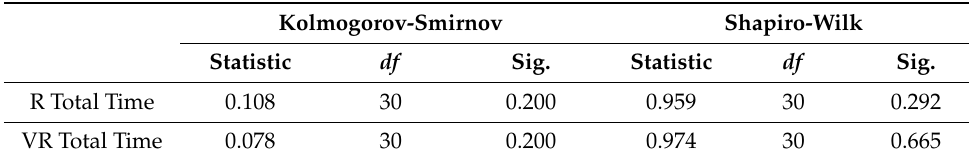
Table 3. Normality assumption test: Total